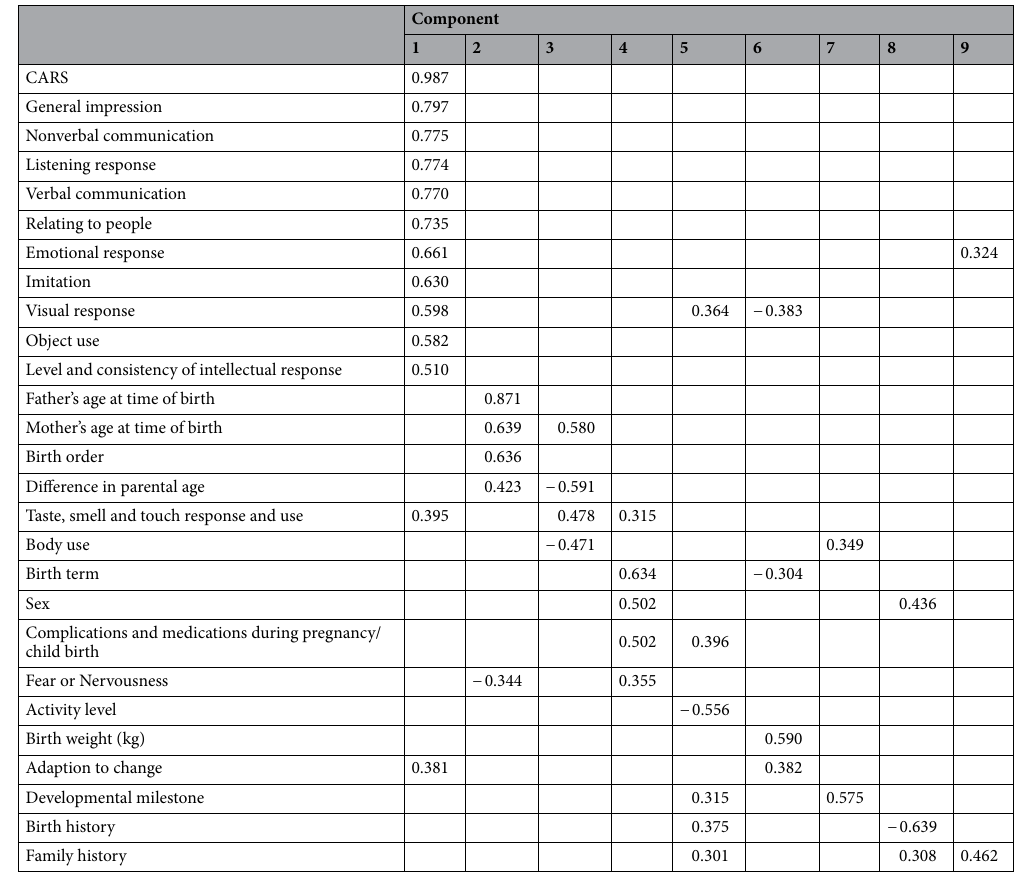
Table 2. Component matrix a table. Extraction method: principal component analysis. a 9 components